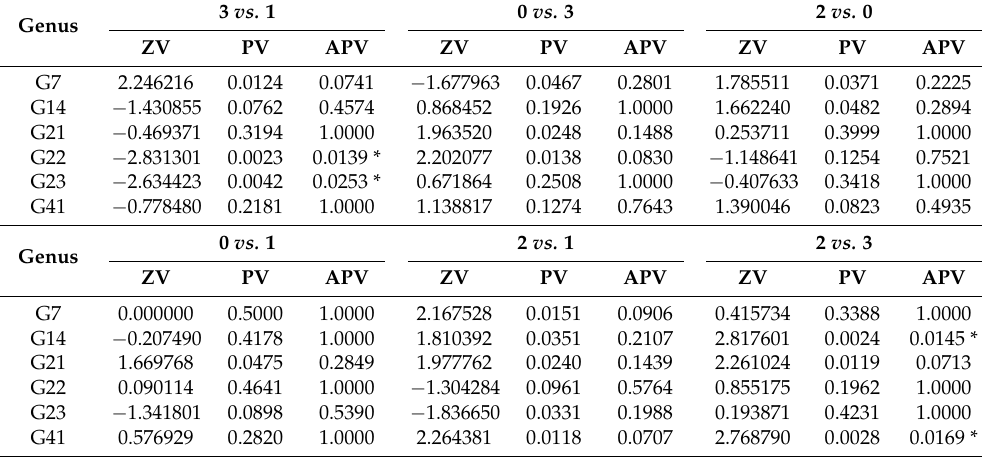
Table 3. Post hoc Dunn test results for each typology comparison for each genus that had a significant Kruskal–Wallis result, including the Genus Identifier, Z -Value (ZV), p Value (PV), Adjusted PV